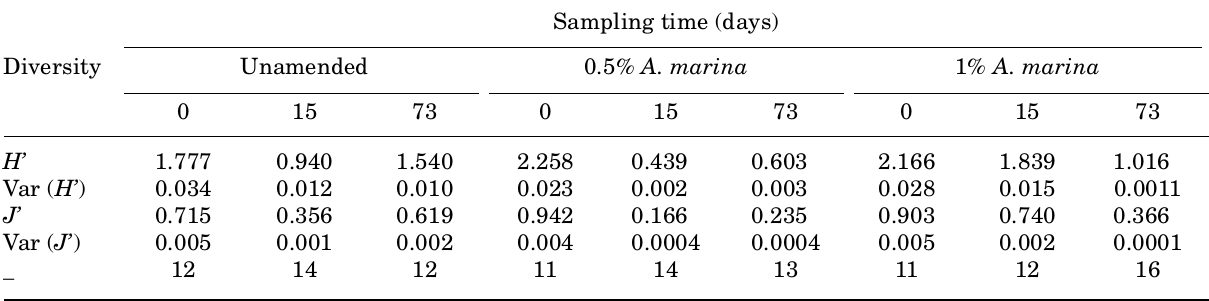
Table 3. General diversity ( H’ ), equitability ( J’ ) and species richness ( S ) of the fungal communities in Avicennia marina -amended soils (0, 0.5 and 1%) at various sampling dates (0, 15, 73 days). Var ( H’ ) = variance of H’ ; Var ( J’ ) = variance of J’